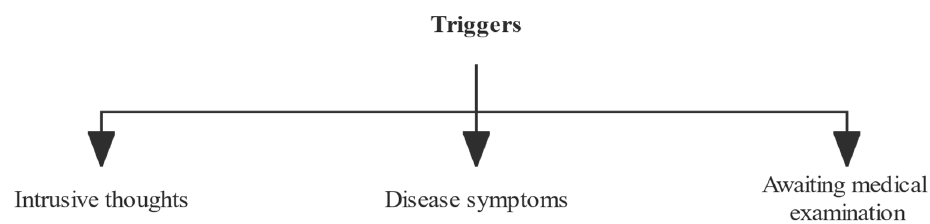
Figure 1. Theme analysis of triggers for fear of cancer recurrence.